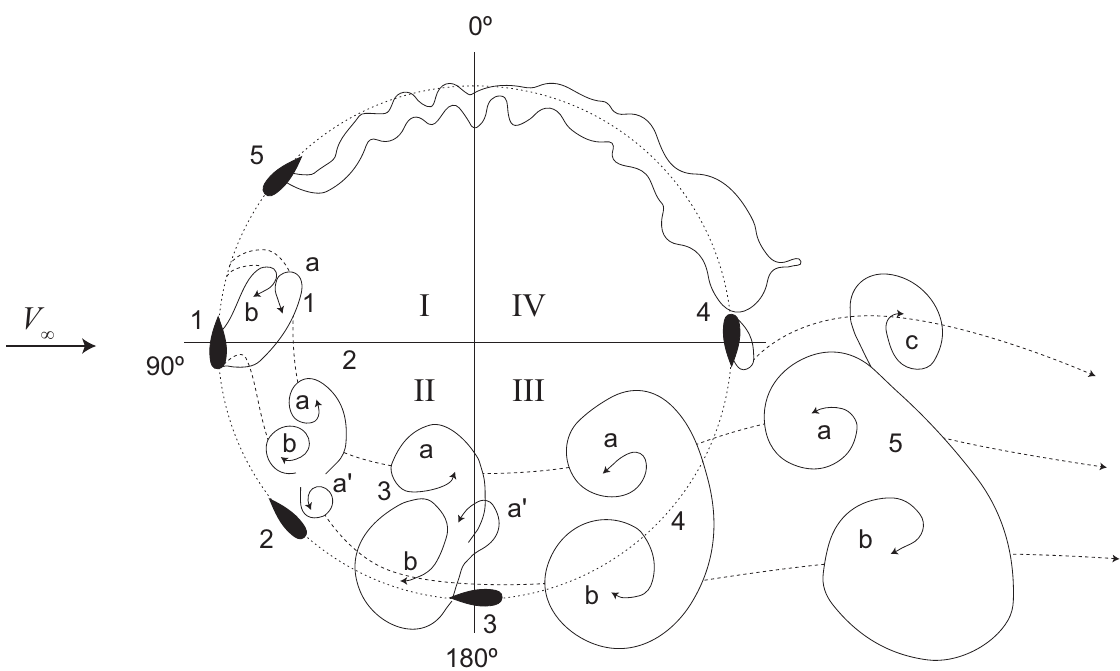
Figure 2. Flow visualization in the dynamic stall condition at λ = 2 . 14 , taken from